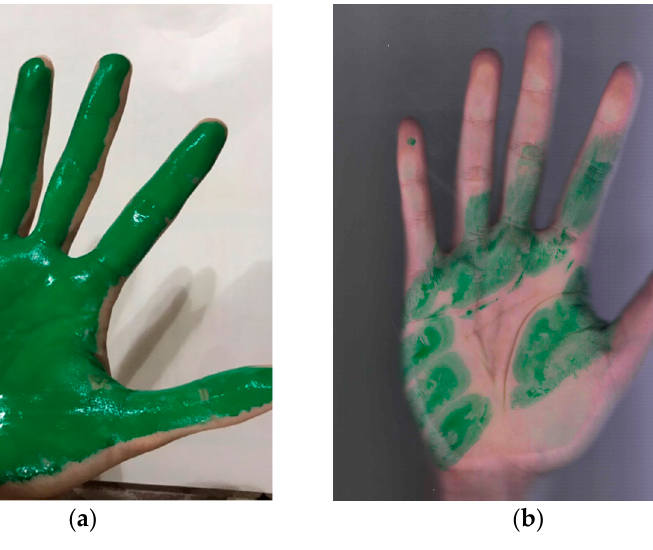
Figure 5. Contact areas during the handshake, as deduced experimentally: ( a ) green ink that was applied to the palm and fingers of each participant’s right hand; ( b , c ) green ink was transferred to another participant’s hand during a handshake.